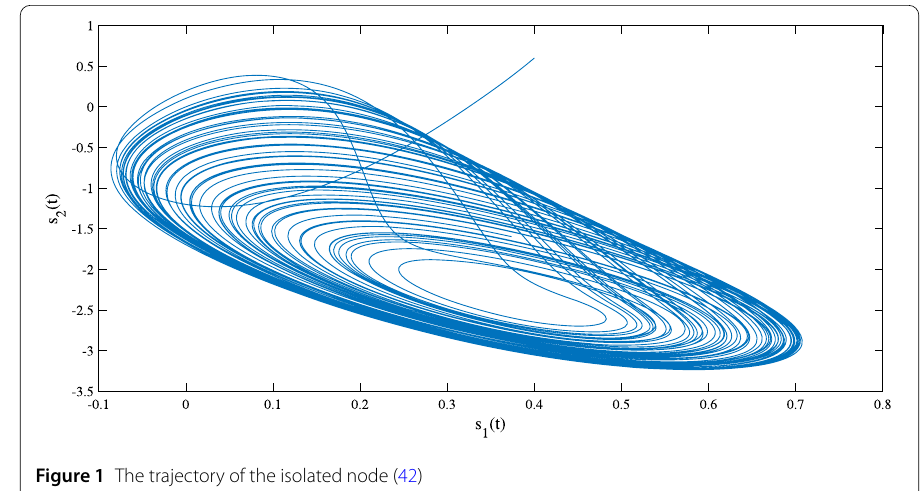
Figure 1 The trajectory of the isolated node (42)